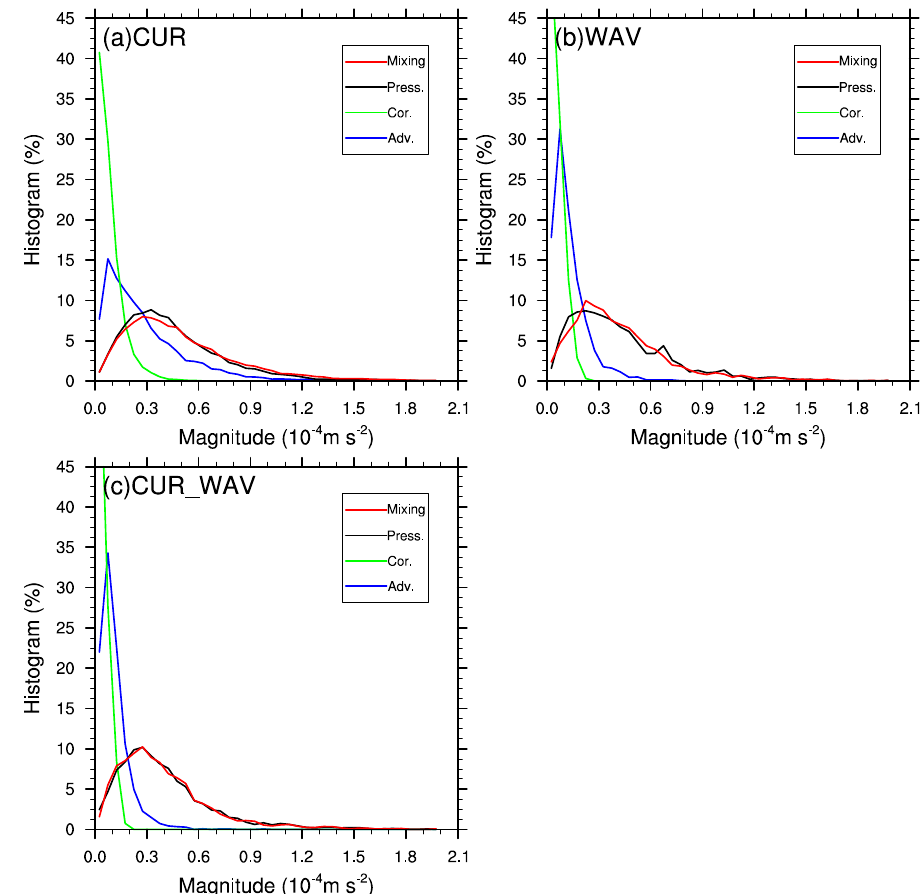
Figure 13. Histograms of 30 day averaged di ff erential vertical mixing (red), horizontal pressure gradient (black), horizontal advection (blue), and Coriolis force terms of PBL momentum budget analysis between ( a ) CUR and CTL, ( b ) WAV and CTL, and ( c ) CUR_WAV and